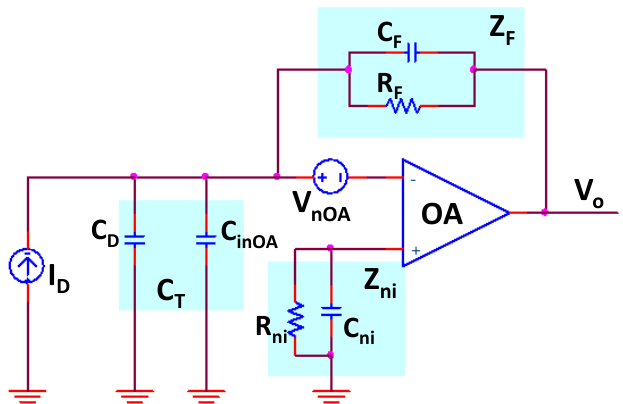
Figure 8. I/V converter equivalent